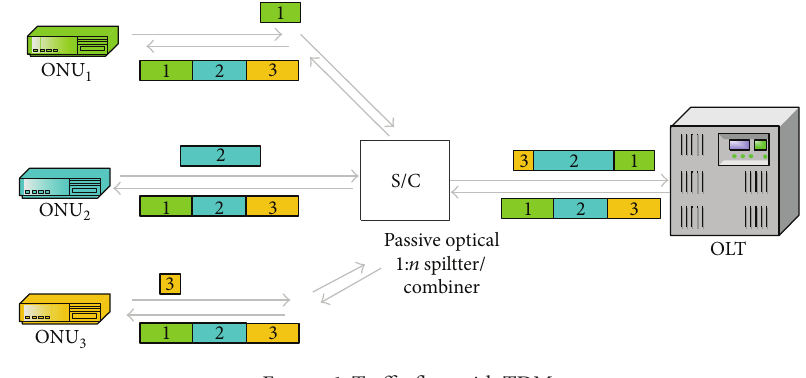
Figure 1: Traffic flow with